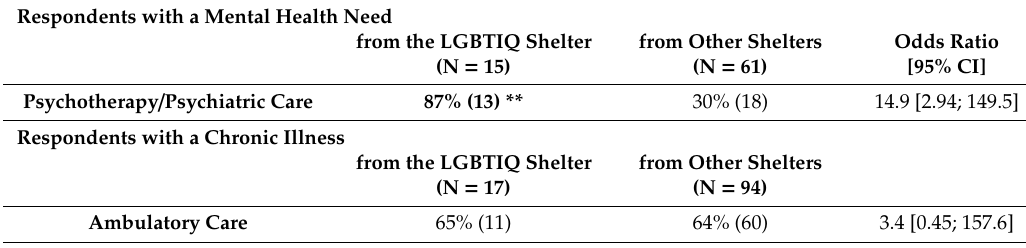
Table 4. Healthcare utilization among respondents with chronic and mental health needs (in %